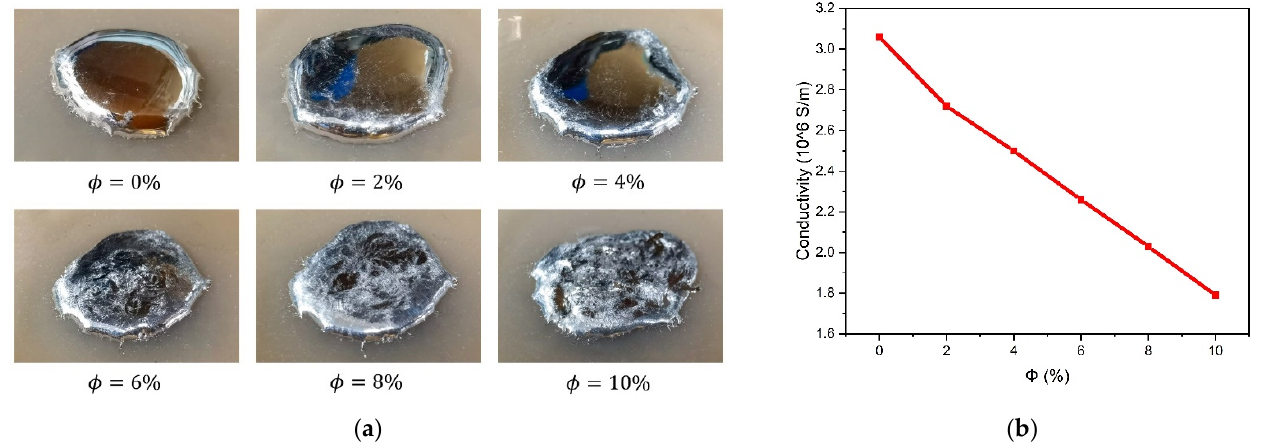
Figure 2. ( a ) Photographs of Ni-GaIn on silicone gel substrate with different mixing ratios of Ni micro particles; ( b ) Change of conductivity with increasing 𝜙 .